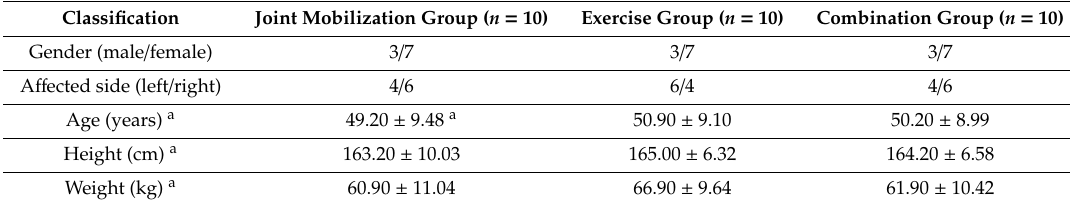
Table 1. Subject characteristics.